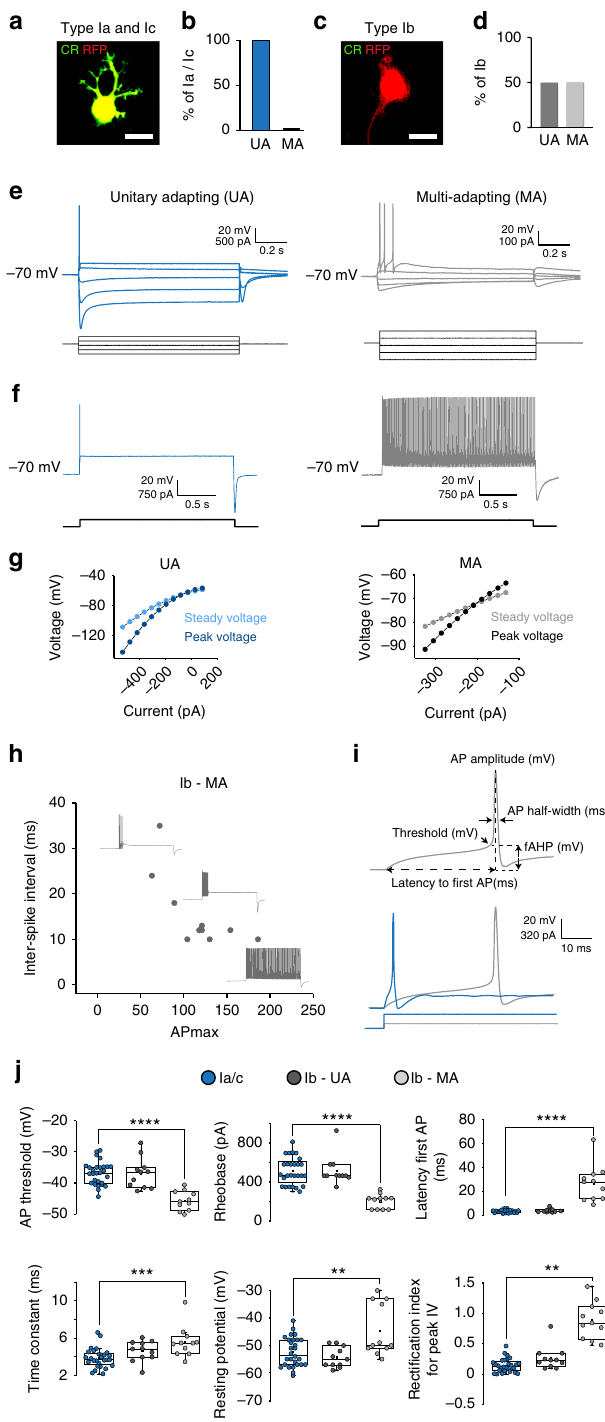
channels 22 . VGICs exhibited extensive differential expression pro fi les amongst the different types of SG neurons, sharply distinguishing type II from type I neurons (Fig. 3a – f). Although Ca v , Na v , and HCN channels families showed modest differences amongst the different subclasses of type I neurons, K v channels differed substantially in these neuron types. Activation of K v channels shapes the pattern of neuronal fi ring and excitability and drives the rate of adaptation to sustained stimuli 23 . Their differential expression could participate in the expected distinct